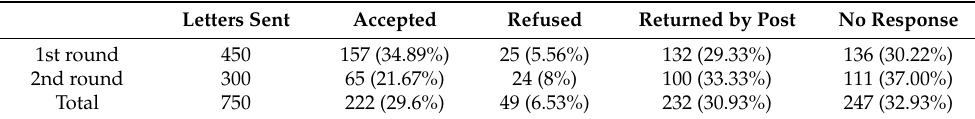
Table 2. Recruitment of the selected adoptees in Catalonia from Russia and